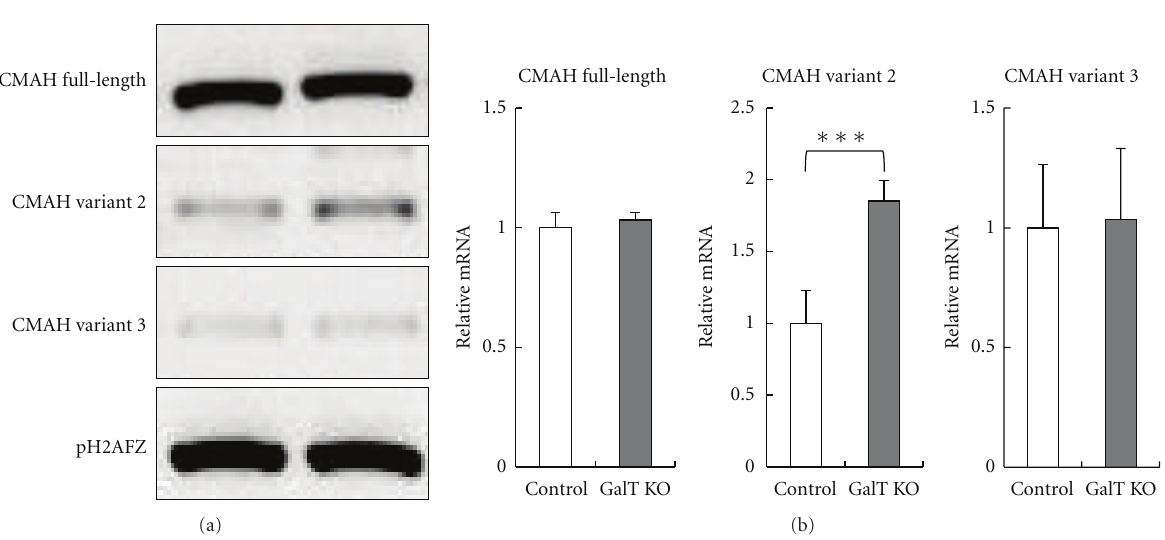
SSP no. indicates the number of spots identified by PDQuest. Score/SC indicates MASCOT score/Sequence coverage.